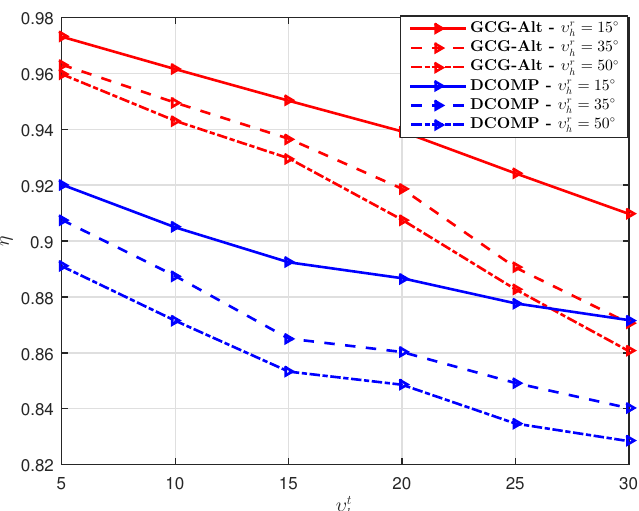
Figure 9. Comparison of η of the GCG-Alt estimator and the DCOMP estimator under the USPA system, where N t = 64, N r = 16, K = 1,PNR = 10 dB, S = 16, T = 16, υ t v = 0 ◦ , and υ r v = 6 ◦